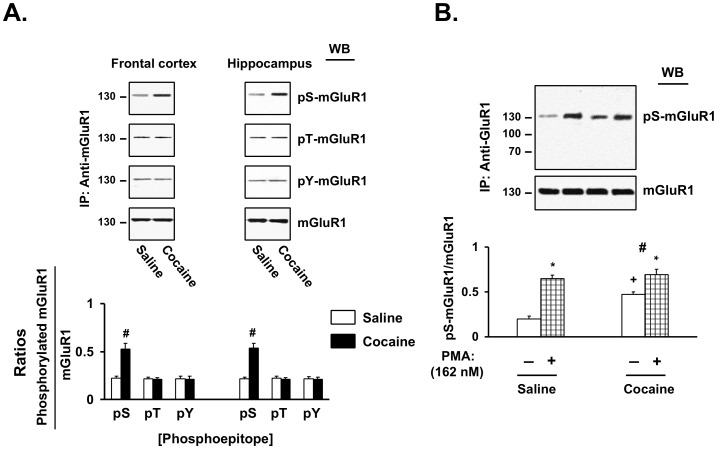
Serine phosphorylation of mGluR1 is elevated in FCX and hippocampi of prenatal cocaine-exposed P21 rats.(A) Levels of Serine (S), Threonine (T) and tyrosine (Y) phosphorylation on purified native mGluR1 from prenatal saline- and cocaine-exposed P21 rats were determined in immunoprecipitates of immobilized anti-mGluR1 by Western blot using specific antibodies directed against each phospho-epitope. (B) pS-mGluR1 levels in immobilized mGluR1 immunoprecipitates of Kreb’s-Ringer (K-R) and 162 nM PMA treated FCX synaptic membrane extracts from prenatal saline- and cocaine-exposed P21 rats. The obtained protein bands were quantified by densitometric scanning of the blots. Data are represented as means ± s.e.m. of the ratios of phosphorylated mGluR1/total mGluR1 optical intensities. n = 4 for each group. *p<0.01 comparing the pS-mGluR1 levels induced by PMA vs. K-R in each treatment group. +p<0.01 comparing the levels of pS-mGluR1 in prenatal cocaine- to saline-exposed groups by two-tailed Student’s t test. #p<0.01 comparing the levels of PMA-induced pS-mGluR1 isolated from prenatal cocaine- to saline-treated rats by two-tailed Student’s t test. No between-group differences in the levels of mGluR1were detected.